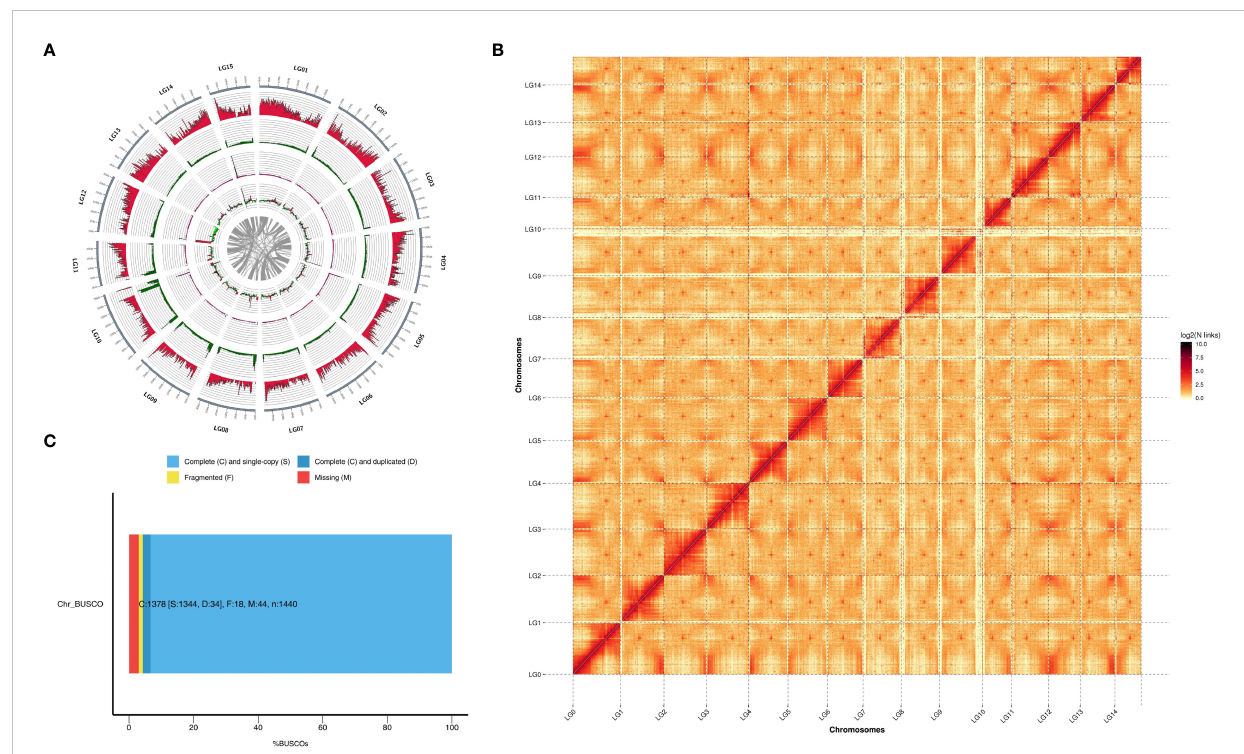
FIGURE 1 The characteristics of yellowhorn XsoG11 genome assembly. (A) The yellowhorn genome feature. From outer-most track to innermost track: gene density, transposable element density, repeat sequence density, GC content, and Intra-genome collinear blocks. (B) Buscos of complete genome. (C) Contact map of Hi-C links among 14 pseudochromosomes.